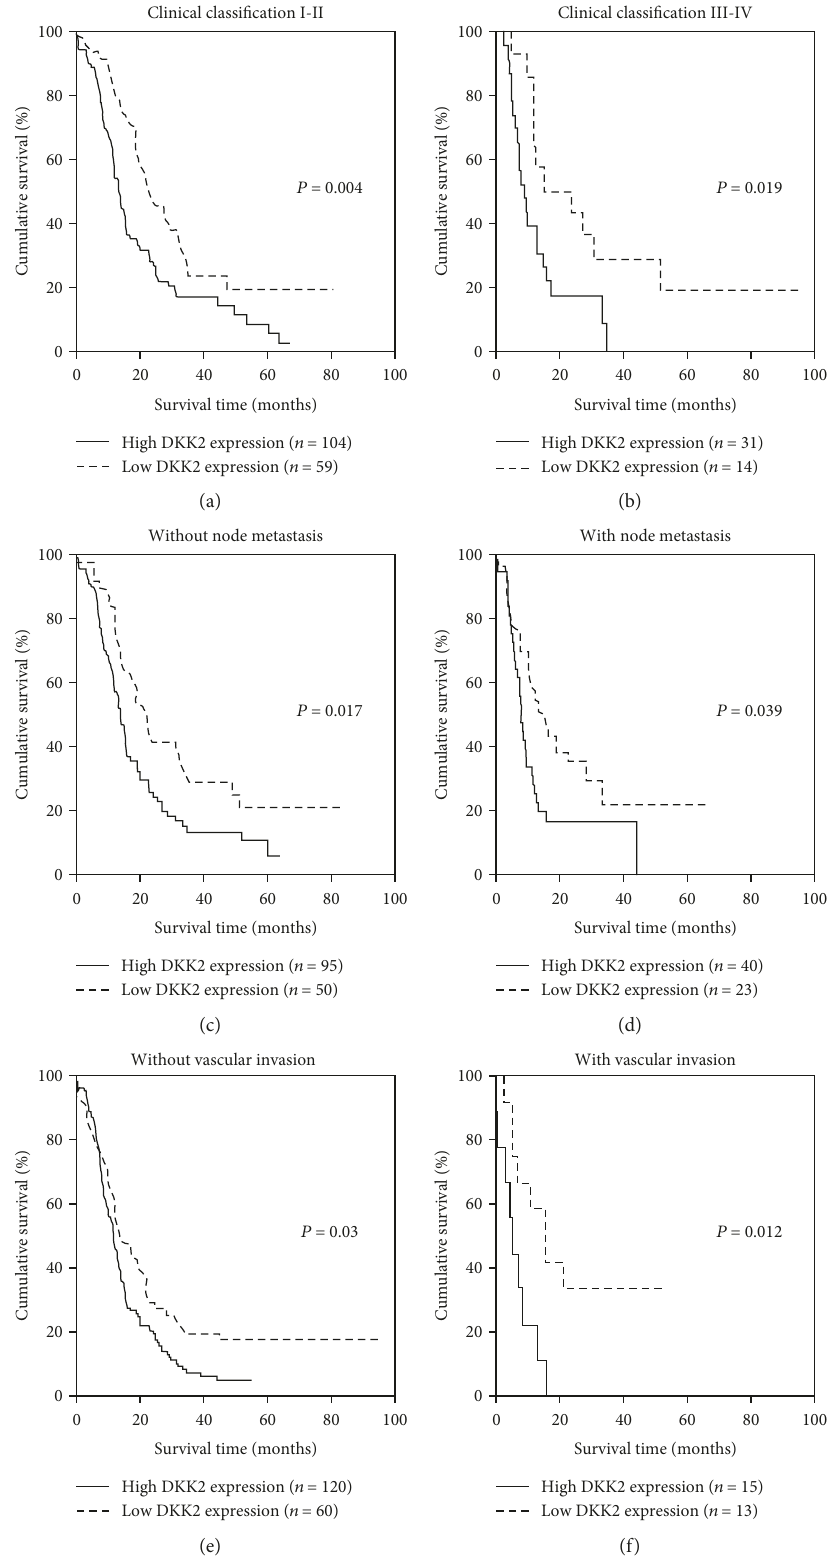
Figure 2: Prognostic signi fi cance of DKK2 assessed in PDAC patients classi fi ed by three conditions. The correlation between DKK2 expression and overall survival rate with patients grouped by clinical classi fi cation I-II stage (a), clinical classi fi cation III-IV stage (b), without node metastasis (c), with node metastasis (d), without vascular invasion (e), and with vascular invasion